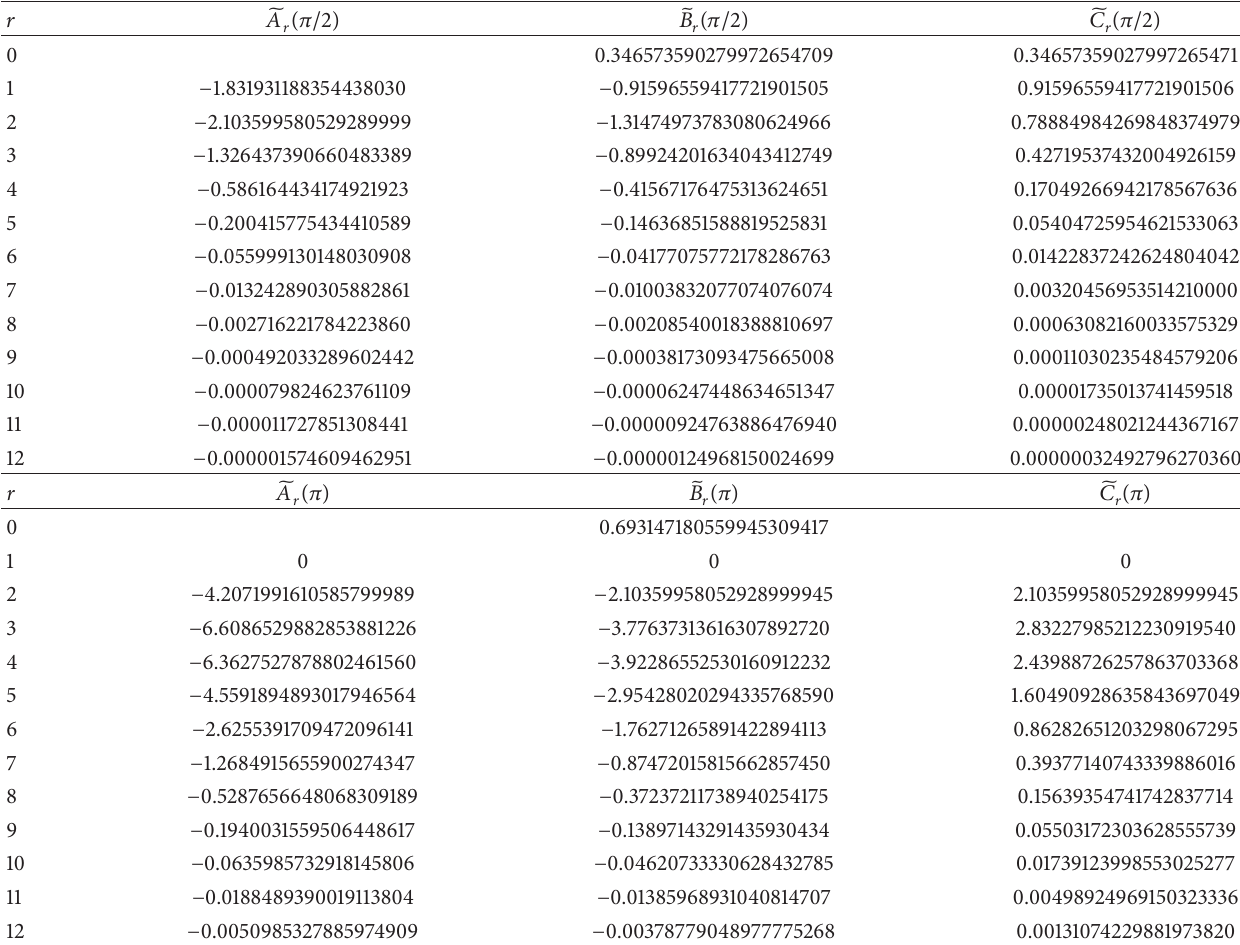
Table 2: Calculated values of the magnitudes 𝑟 ̃𝐴